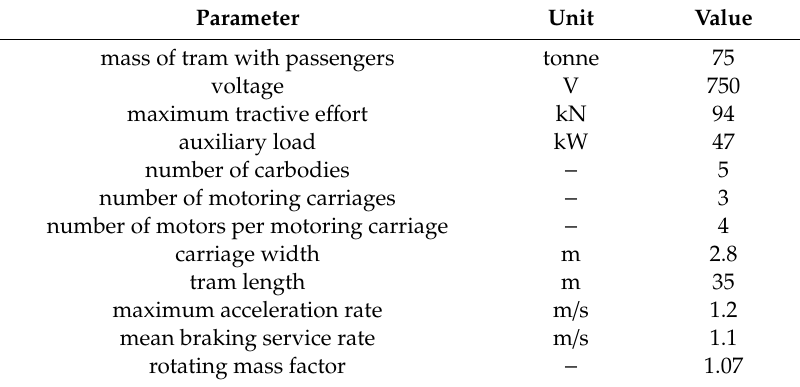
Table A5. Tram input